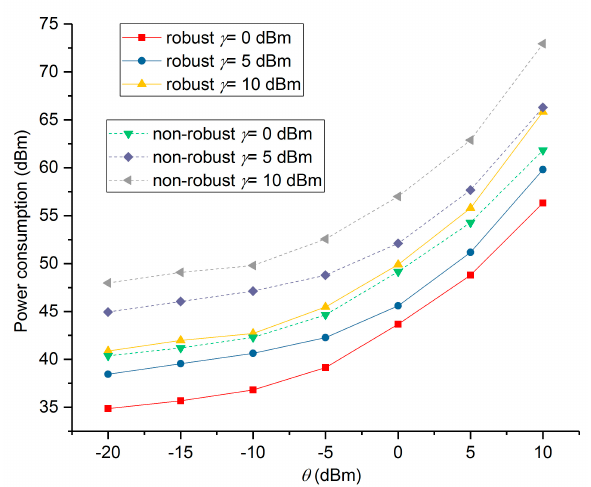
Figure 2. Power consumption versus energy harvesting (EH) threshold with different signal-to-interference-plus-noise ratio (SINR) thresholds.